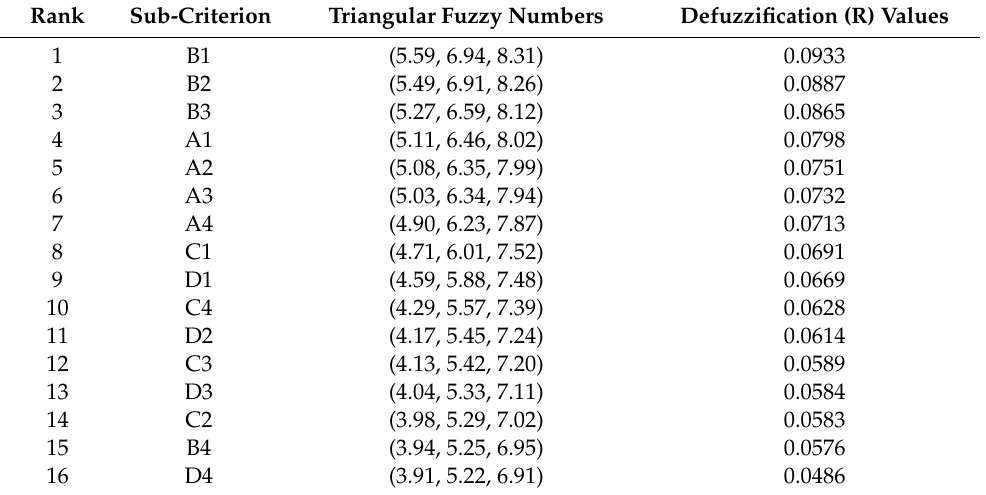
Table 1. FAHP questionnaire analysis result for Chinese